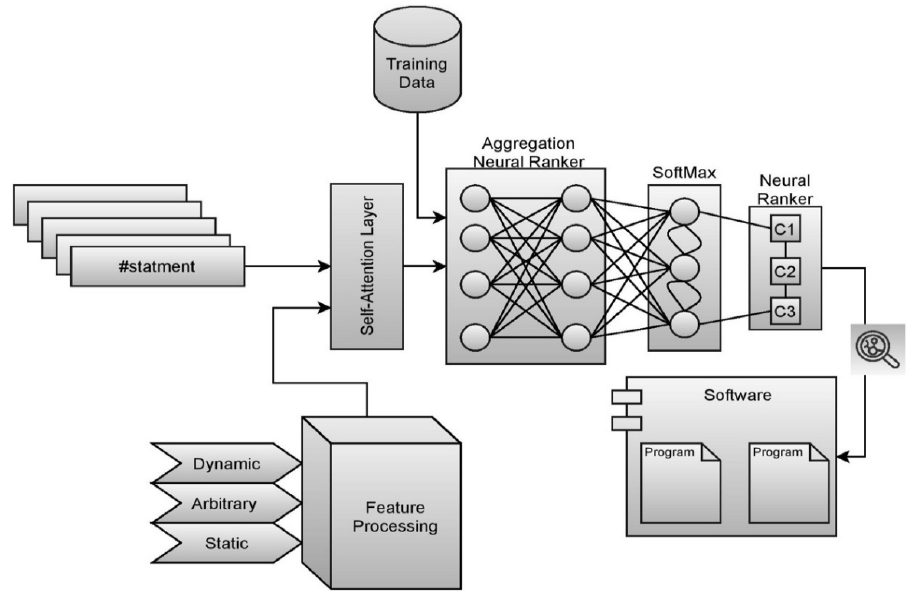
Figure 3. Represents the layered architecture of the fault localization